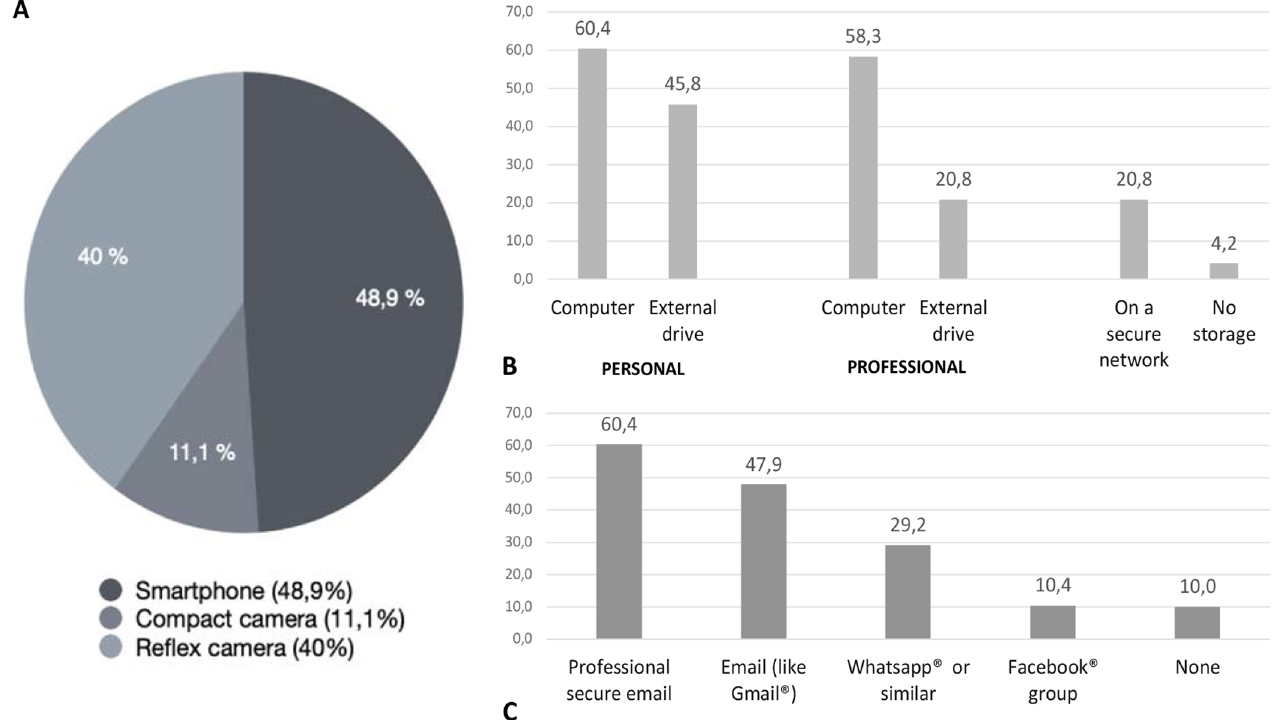
Fig. 3. Means of taking, storing and sharing photos? (A) Photo material; (B) Storage material; (C) Means of sharing.